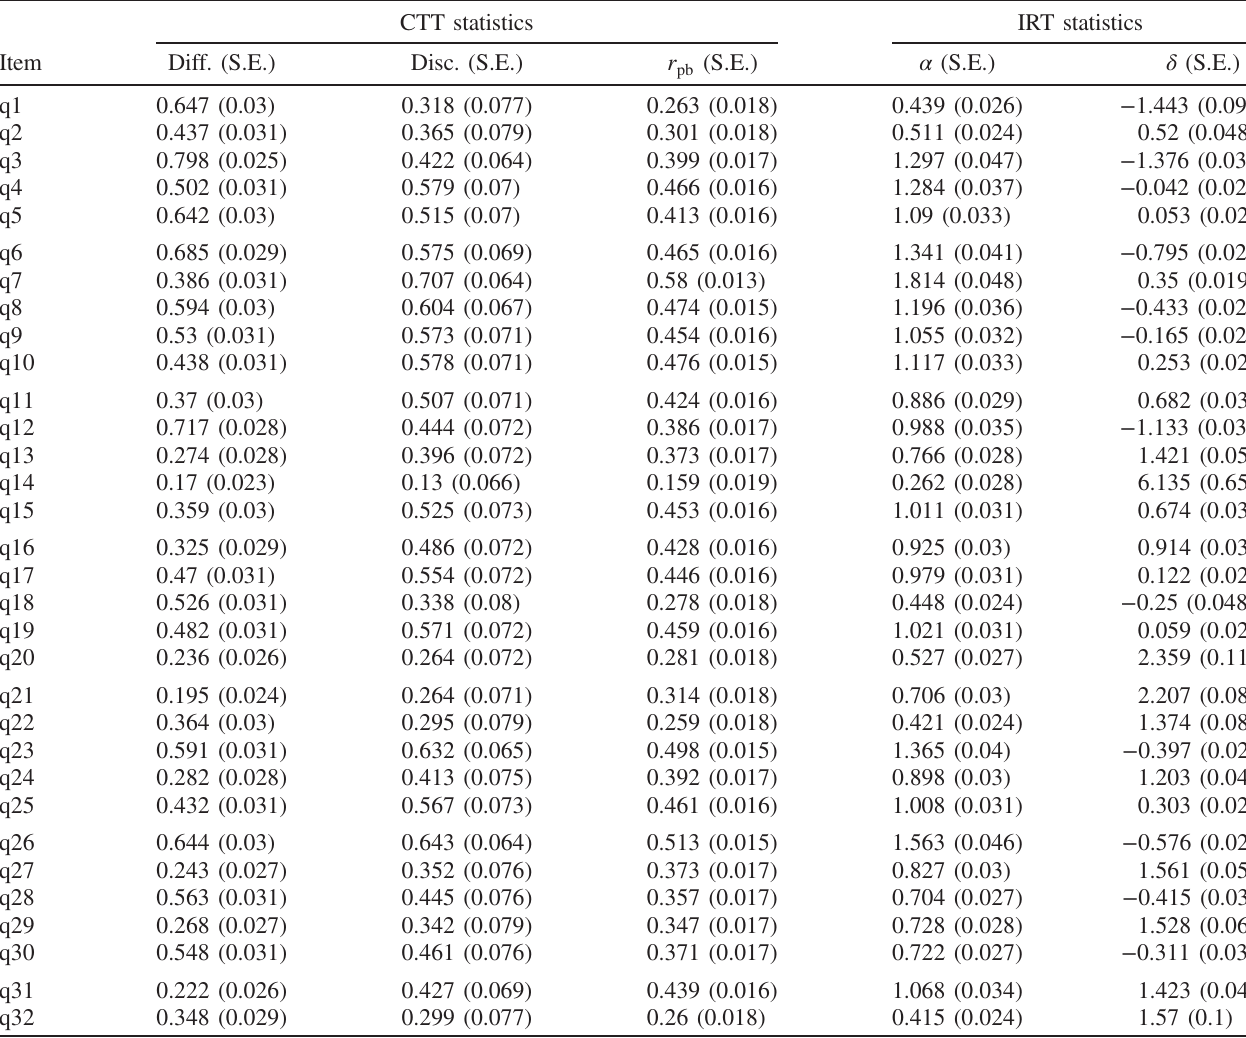
TABLE V. CSEM ’ s CTT and IRT item parameters, in the CSEM scale, with standard